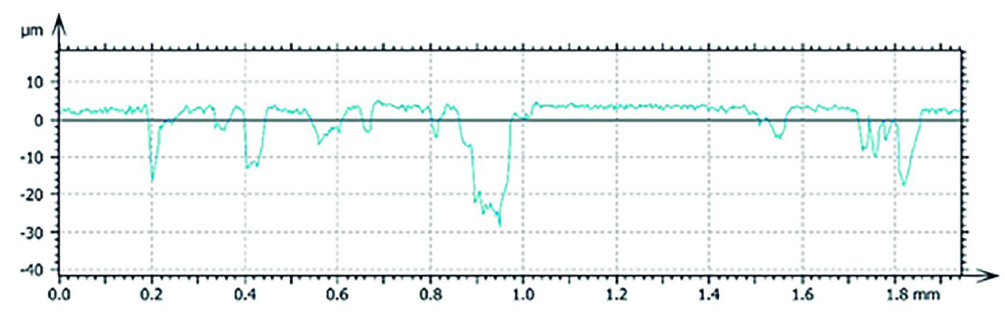
Figure 7. Profile with depths corresponding a pits obtained from NiTiCu surface after polarization.